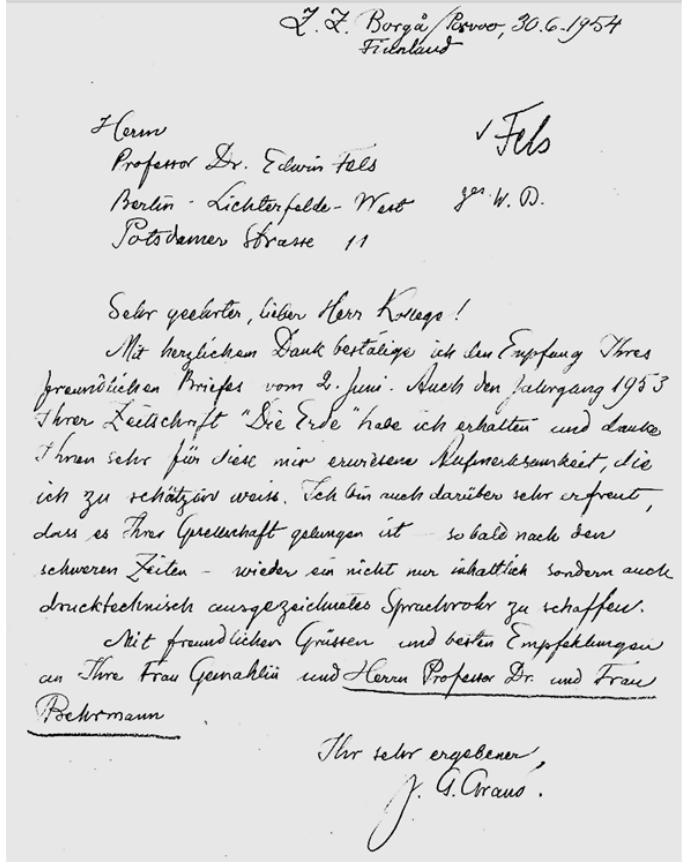
Figure 7: Letter of thanks of Granö to Prof. Edwin Fels, Geographic Society in Berlin,